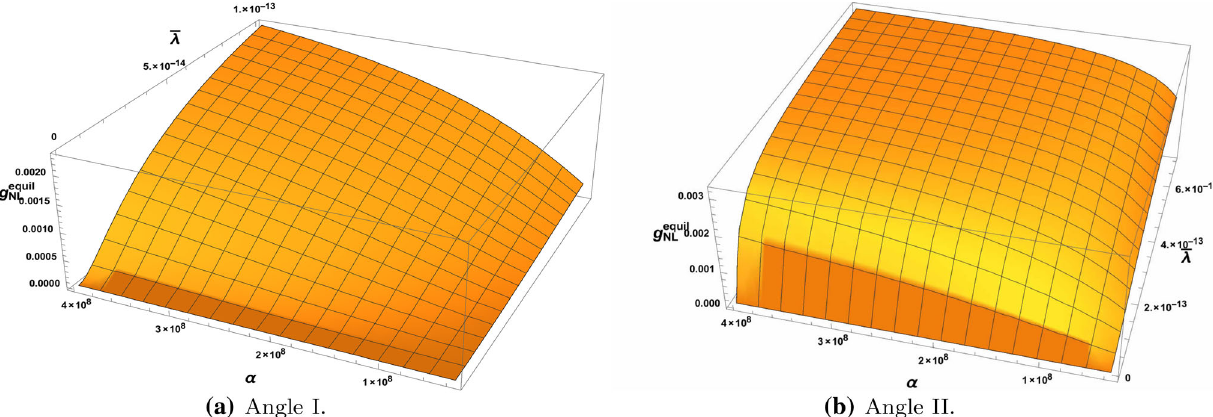
Fig. 25 Representative 3D diagram for equilateral non-Gaussian three point amplitude vs. the model parameters α and ¯ λ for N cmb = 60 in two different angular views